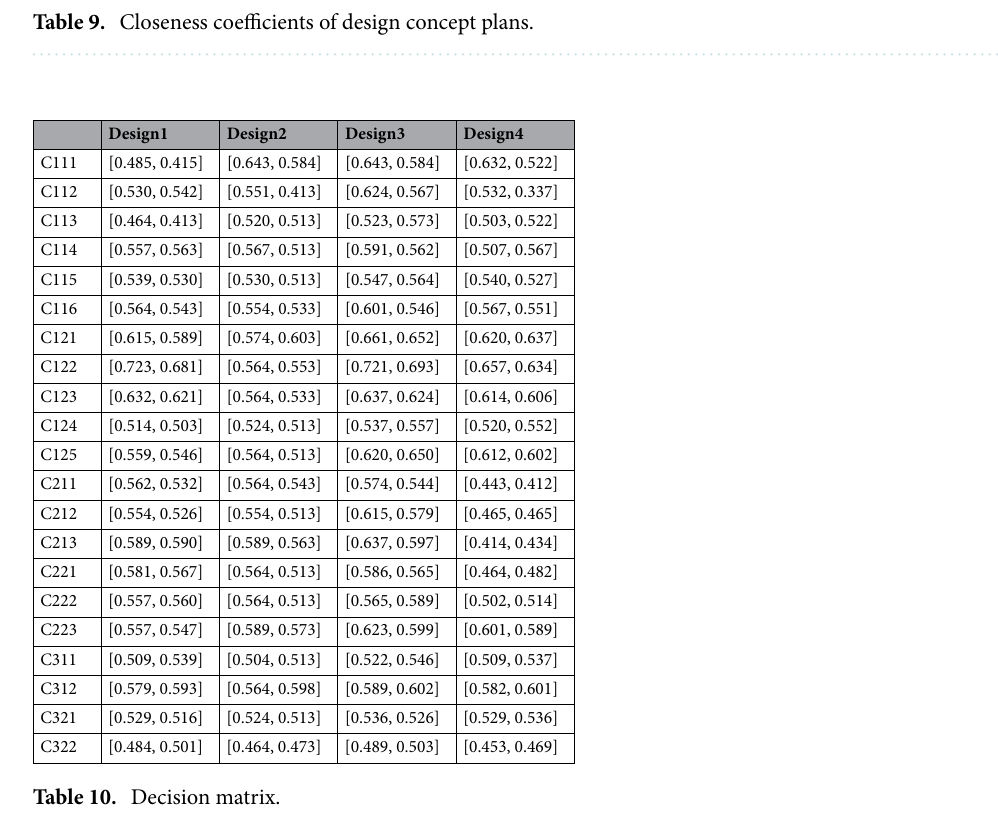
Table 10. Decision matrix.